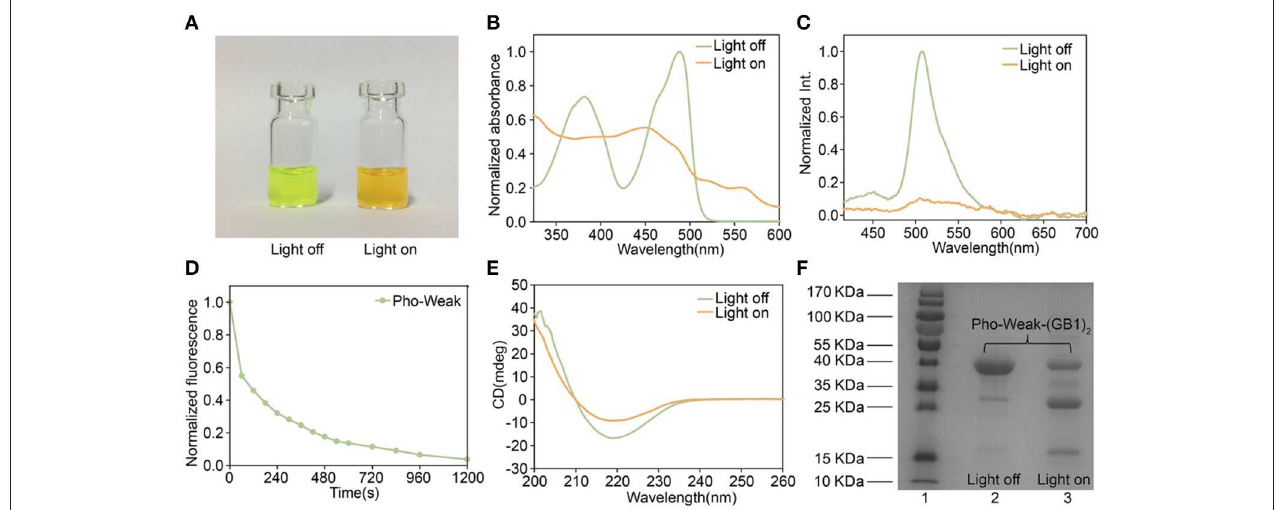
FIGURE 3 | Characterization of Pho-Weak. (A) Photographs of Pho-Weak solutions before and after light illumination. (B) UV–vis absorbance changes after photocleavage. (C) Fluorescence spectra before and after photocleavage excited at 405nm. (D) Kinetics of dissociation, as determined by the decrease of green fluorescence after illumination. (E) Circular dichroism spectra before and after photocleavage. (F) SDS-PAGE analysis of Pho-Weak-(GB1) 2 before and after photocleavage. The band at ∼ 13 kDa corresponds to the fragment containing (GB1) 2 .